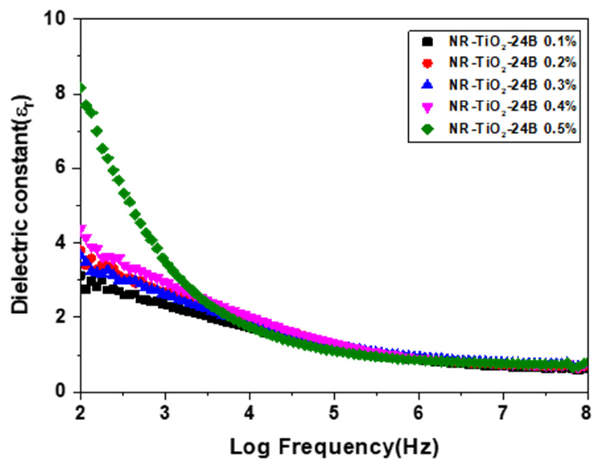
Figure 8. Dielectric constant of the NR-TiO 2 -B24h 0.1–0.5%wt. The dependence of the output performance on the contact-separation frequency were also studied. The voltage and current outputs of the NR-TiO 2 -B24h 0.5%wt TENG were measured at operation frequencies ranging from 2–10 Hz, as presented in Figure 9a,b, respectively. It was found that electrical outputs depended on working frequency, and that the highest peak-to-peak voltage and current were 204 V and 13 µA, respectively, at a working frequency of 10 Hz. The increased electrical output was caused by charge retention on the surface due to a short contact-separation cycle at high frequencies.